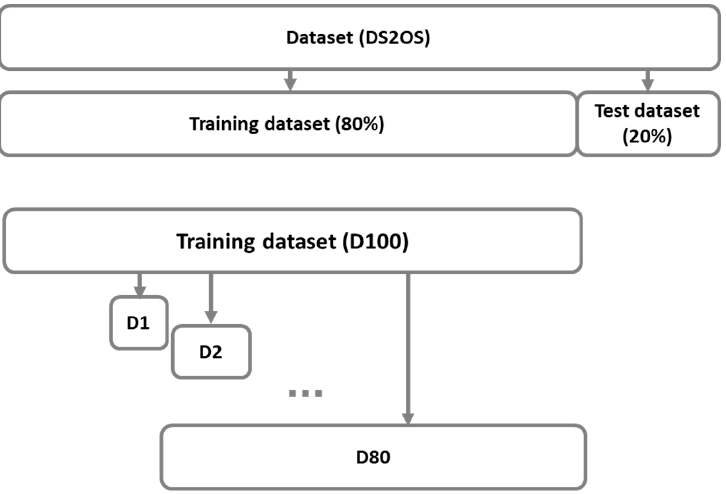
Figure 2. Determination of randomly selected training dataset (80%) and test dataset (20%) from the original dataset (DS2OS), and imbalanced datasets D1, D2, …, D80 from the training dataset (D100).